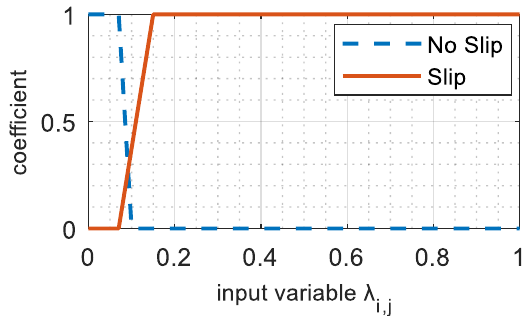
Figure 4. Final fuzzy logic algorithm input variables.